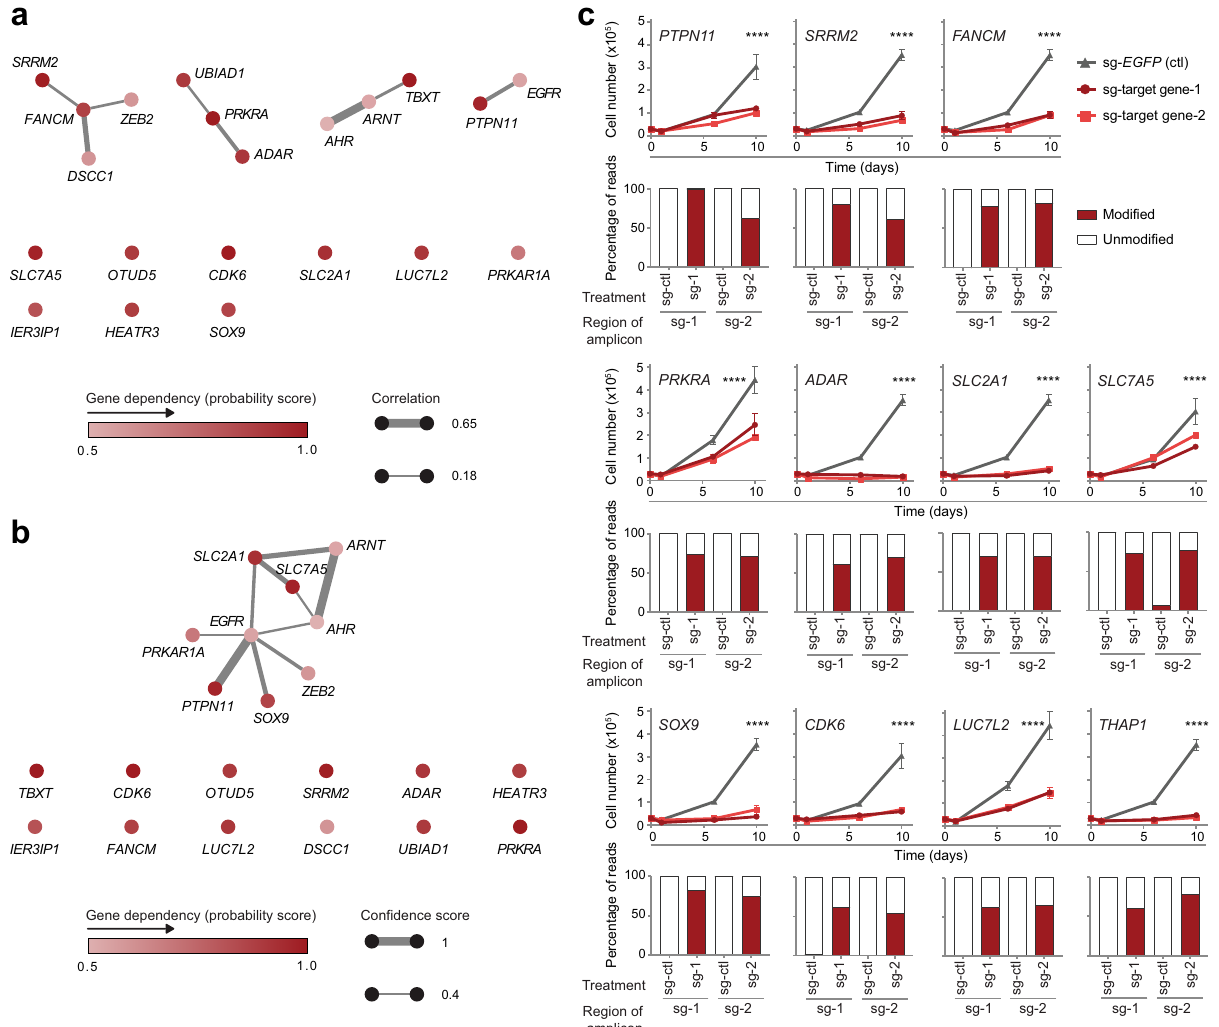
Fig. 2 | Validation of candidate chordoma dependency genes. a Co-essentiality networkforselectivechordomadependencygenes.Nodes:chordomadependency genes, colored by dependency probability scores. Edges: Pearson correlation coef fi cient ≥ 0.18 between dependency pro fi les for connected gene pairs, i.e., dependencyprobabilityscoresacrossall769cancercelllines;edgewidthscaledby correlation coef fi cient. For clarity, we show all genes included in the analysis by listing singletons (geneswithoutconnections exceeding ourthresholds)belowthe connected components of the network. b STRING protein-protein interaction networkforselectivechordomadependencygenes.Nodes:chordomadependency genes,coloredbydependencyprobabilityscores.Edges:putativeinteractionswith a STRING con fi dence score ≥ 0.4; edge width scaled by con fi dence score. c (Top rows) Proliferation of Cas9-expressing UM-Chor1 chordoma cell lines transduced with one of two distinct sgRNAs targeting a candidate dependency gene or a non- targeting sgRNA control. Points represent the mean±s.d. ( n =at least 3 biological samples measured in parallel). **** P <0.0001, derived from a two-way analysis of